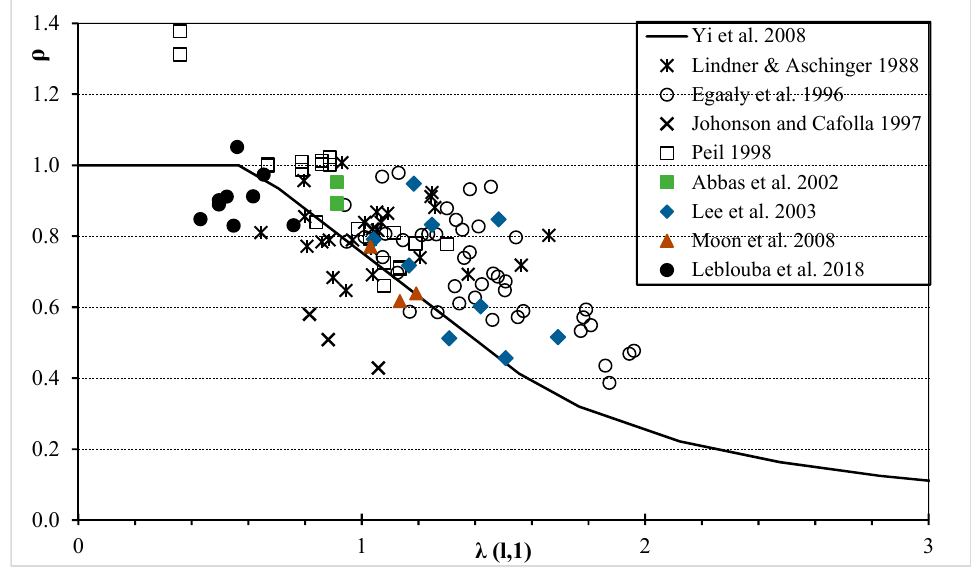
Figure 2. Relation between slenderness interaction shear buckling strength and normalised experimental shear strength.